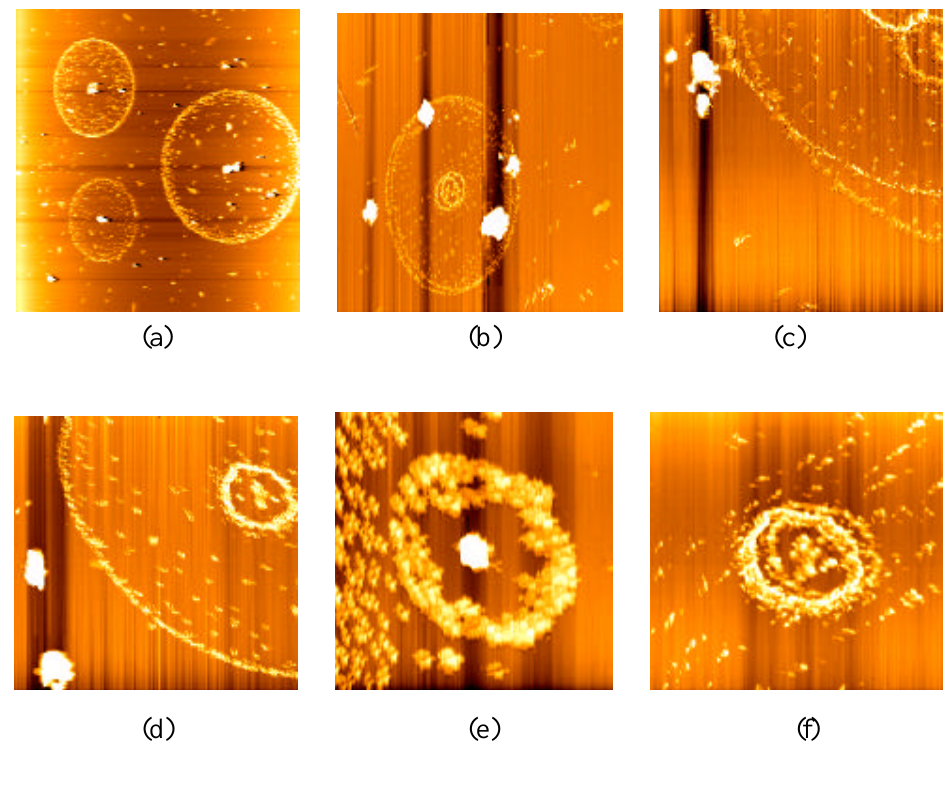
Figure 2. Some aggregation images of Ig